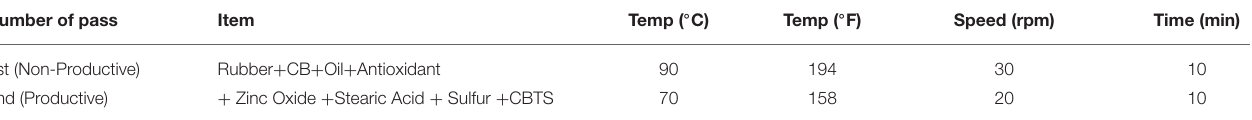
TABLE 2 | Compounding